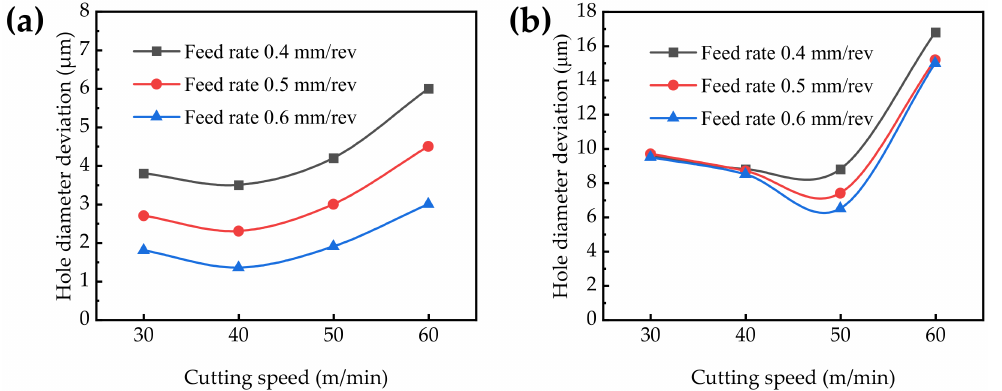
Figure 10. Hole diameter deviation versus different cutting parameters: ( a ) Tool A; ( b ) Tool